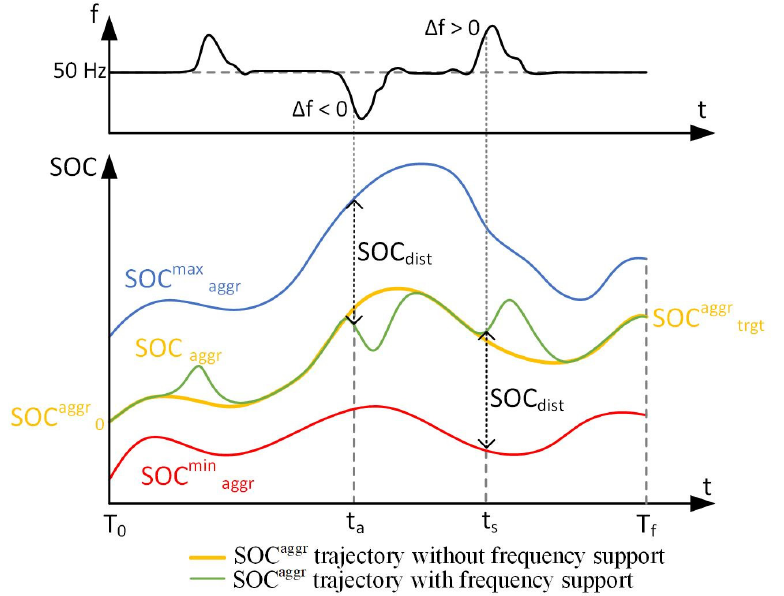
Figure 5. Calculated equivalent battery capacity with/without frequency support implementation .